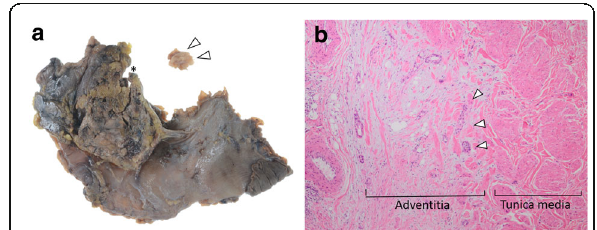
Fig. 6 Macroscopic and microscopic findings of the resected specimen of case 2. a The inferior vena cava (IVC) wall was resected together with the pancreatic head and separated through the pathological examination ( arrowhead ). Asterisk shows the initial site of the resected IVC wall. b Tumor invasion of the adventitia of the IVC wall was observed ( arrowhead ) (hematoxylin and eosin stain, ×40)